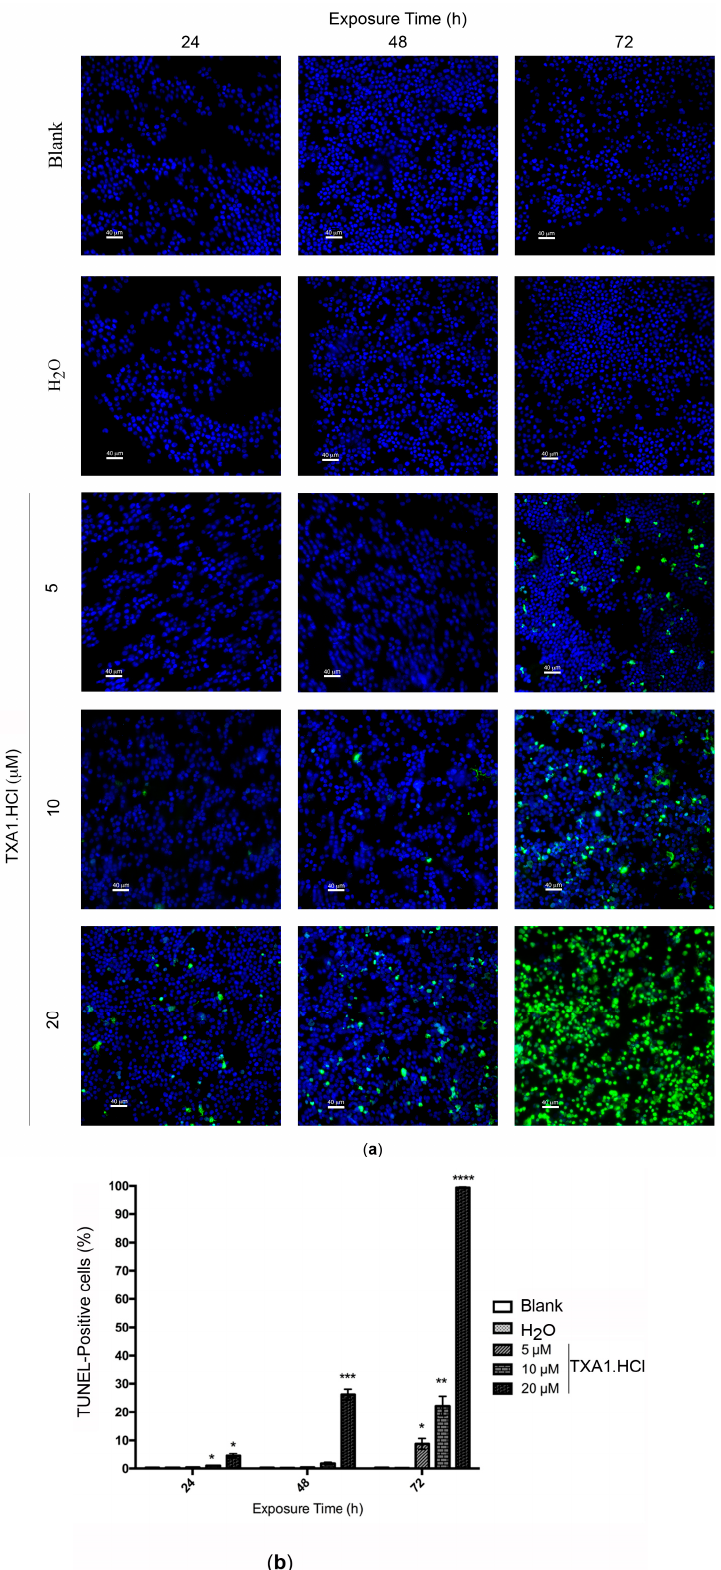
Figure 5. Effect of TXA1·HCl treatment in MCF-7cell death, analyzed with the TUNEL assay. Cells were treated for 24, 48 and 72 h with medium only (Blank), H 2 O and TXA1·HCl (5, 10 and 20 µM). ( a ) Representative fluorescence microscopy images showing increasing TUNEL-positive cells (green) as induced by 5, 10 or 20 µM of TXA1·HCl , while few or no TUNEL-positive cells were observed in control cultures (Blank and H 2 O). DNA was stained with DAPI (blue); bar = 40 µm; ( b ) Quantification of the levels of cell death. Results are the mean ˘ SEM from at least three independent